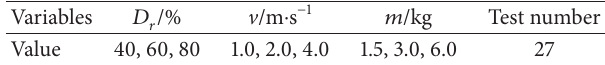
Table 3: Comparison of impact velocity. Table 4: Scheme of the model